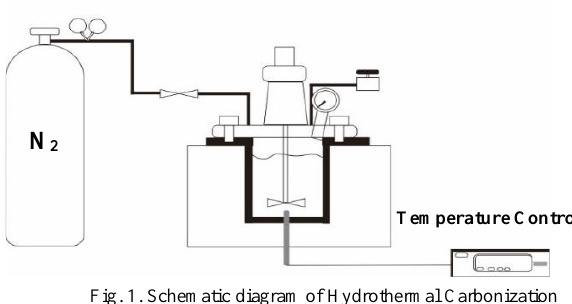
Fig. 1. Schematic diagram of Hydrothermal